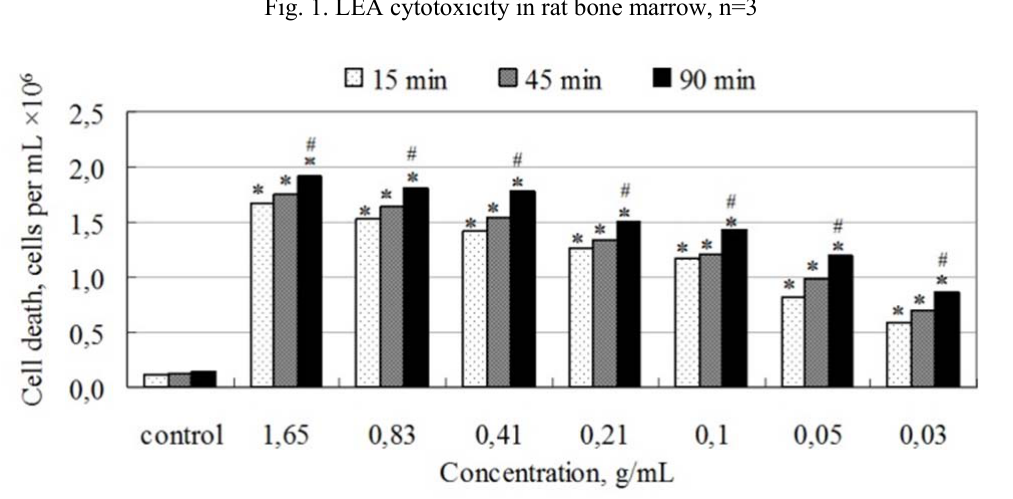
Fig. 1. LEA cytotoxicity in rat bone marrow, n=3